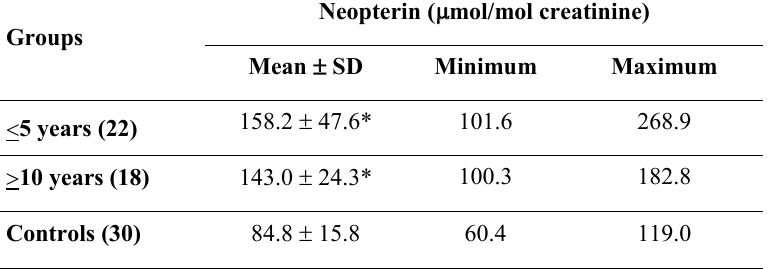
Table 2. Effect of duration period on urinary neopterin concentrations, workers grouped into those with < 5 and > 10 years of working periods * p < 0.05; versus